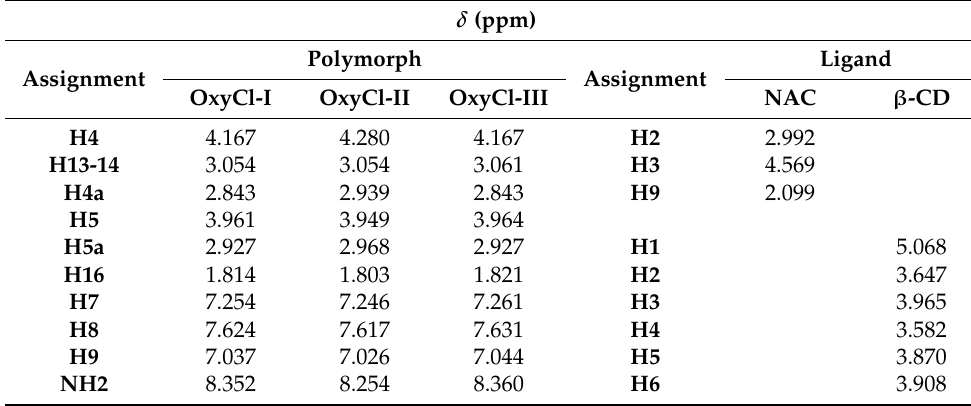
Table 6. 1 H NMR chemical shifts ( δ ) of OxyCl forms, β -CD, and